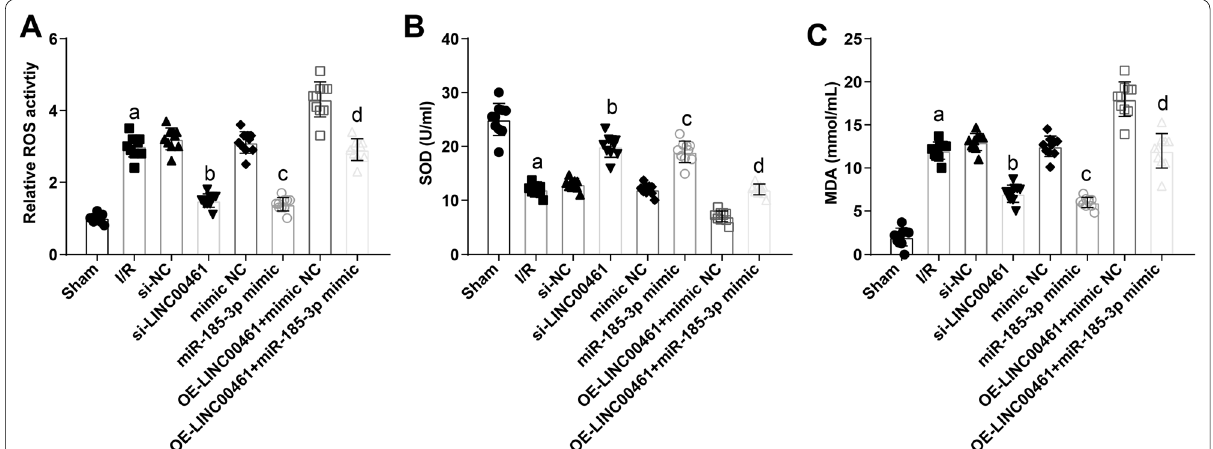
Fig. 7 Restoring miR-185-3p or silencing LINC00461 decrease oxidative stress in the myocardial tissue of I/R mice. A Comparison of ROS levels in myocardial tissue of mice. B Comparison of SOD levels in myocardial tissue of mice. C, Comparison of MDA levels in myocardial tissue of mice. a P < 0.05 vs. the sham group. b P < 0.05 vs. the si-NC group. c P < 0.05 vs. the mimic-NC group. d P < 0.05 vs. the OE-LINC00461